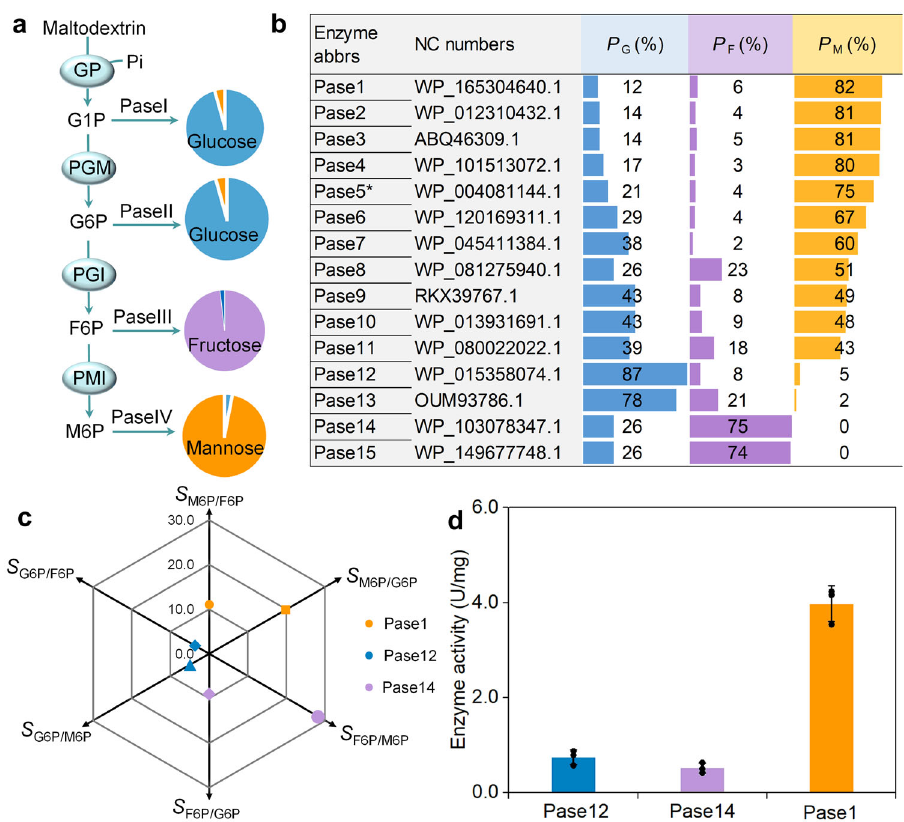
Fig. 1 The phosphatases mining for catalytic speci fi city to particular substrates. a the screening system for candidate phosphatases using maltodextrin as substrate. Pi: phosphate; Pase was the abbreviation of phosphatases. The reaction system containing 10 g/L of maltodextrin, 10 mM of PBS (pH 6.5), 5 mM of MgCl 2 . 0.3 mg/mL of TmGP, 0.2 mg/mL of TkPGM, 0.2 mg/mL of DtPGI/MPI, and 60 µ L of heat-treated or puri fi ed Pases was conducted at 55 °C for 4 h. b The P G/F/M values for different phosphatases were presented. For example, the P M value was calculated by the ratio of mannose concentration to total monosaccharides concentration. P G value indicates the proportion of glucose, and the P F value presents the proportion of fructose. c The S R1/R2 values for Pase1, Pase12 and Pase14. The S M6P/F6P of Pase1 displayed the ratio of activity of Pase1 to M6P over F6P. d The enzyme activity of Pase1 to M6P, Pase12 to G6P and Pase14 to F6P were presented. Data are presented as mean values + / − SD ( n = 3 independent experiments). Source data for d are provided as a Source Data fi